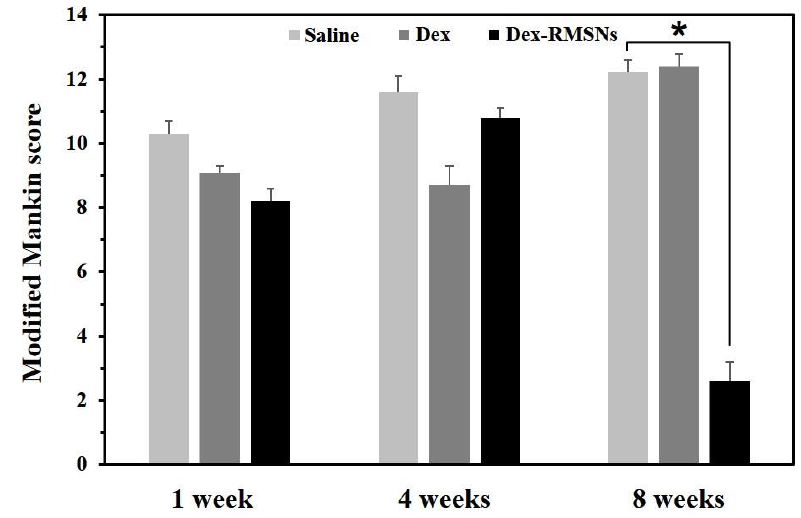
Figure 9. Modified Mankin scores in different parts of knee joints after treatments of saline, Dex only, and Dex-RMSNs at 1, 4, and 8 weeks. The error bar refers to the standard deviation ( n = 6, mean ± standard deviation, * P < 0.001).